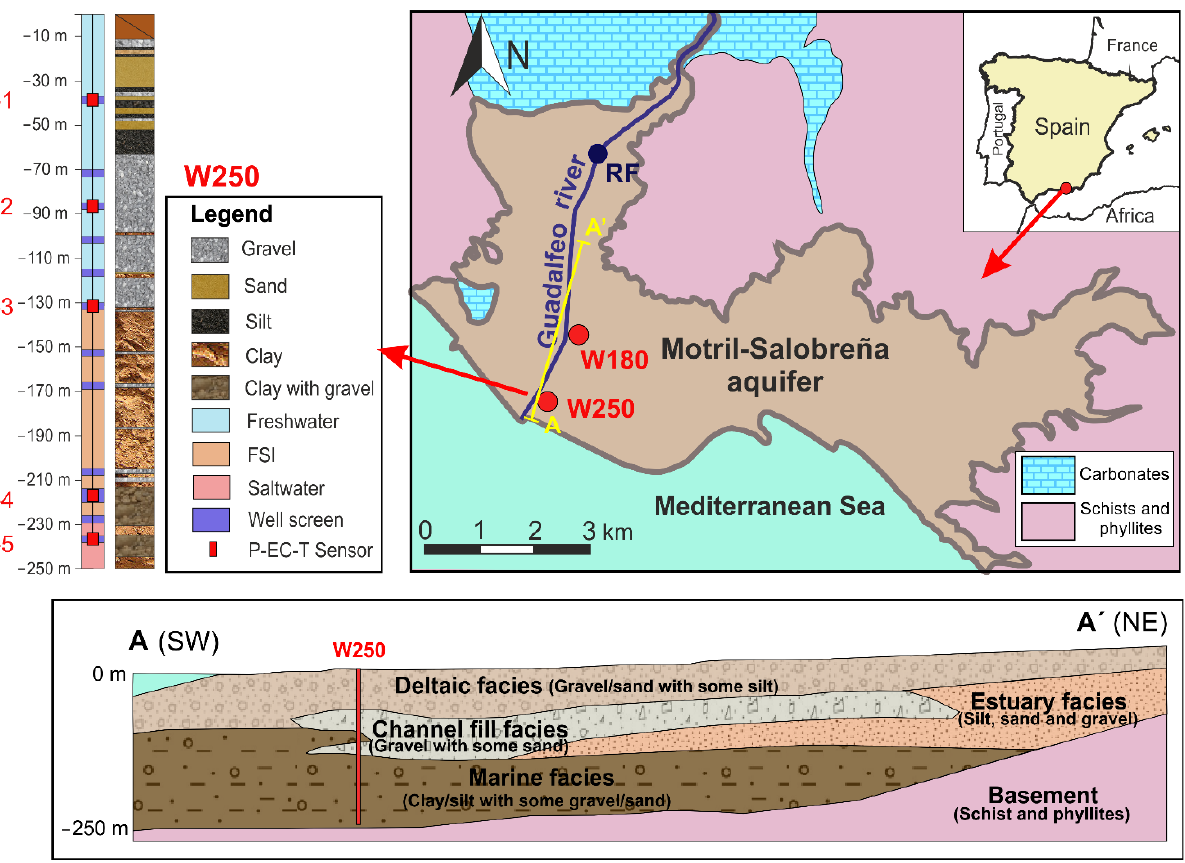
Figure 2. Location of the Motril-Salobreña aquifer, research boreholes, and the measurement point of the river flow (RF). Cross section of the depositional environments at the study area (modified from Olsen [48]).